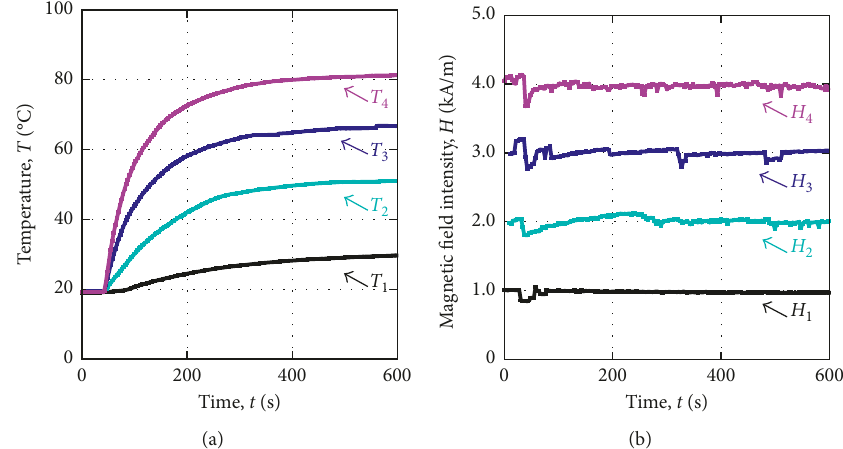
Figure 6: (a) The time course of temperature for the four RMF examples at a frequency of 100kHz. (b) The time course of the amplitude of the RMF.